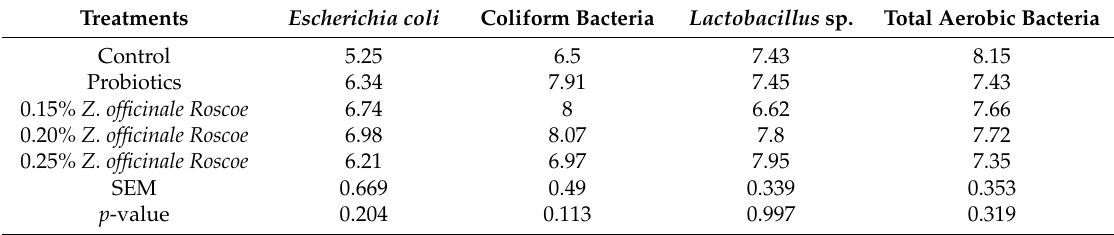
Table 6. Effect of experimental diets on ileum microbiota (log 10 CFU/g) of broilers.